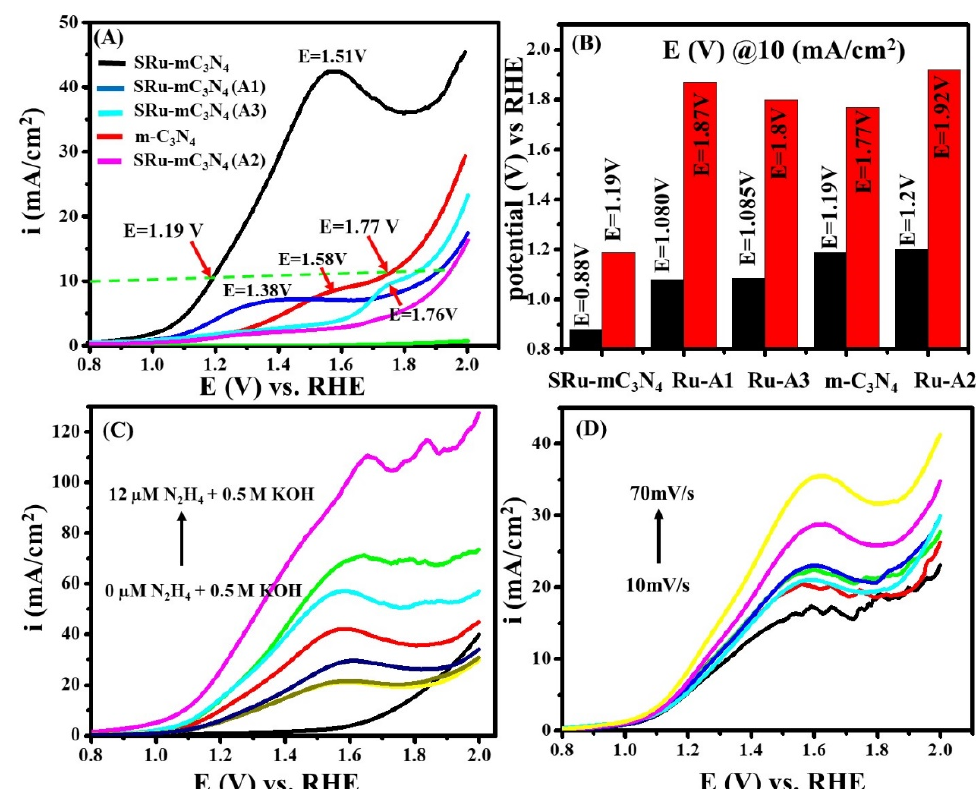
Figure 3. ( A ) Superimposed linear sweep voltammetry (LSV) for the bare GCE (green colour), SRu- mC 3 N 4 (A2), m-C 3 N 4 , SRu-mC 3 N 4 (A3), SRu-mC 3 N 4 (A1), and SRu-mC 3 N 4 in 6 μM N 2 H 4 + 0.5 M KOH at 50 mV/s. ( B ) Histogram of onset (black bar) oxidation potential and 10 mA/cm 2 (red bar) current density vs. RHE. Superimposed LSV for ( C ) SRu-mC 3 N 4 for different concentrations (0, 1, 2, 4, 6, 8, 10, 12 μM—black, yellow, dark yellow, blue, red, cyan, green, magenta in colour respectively) of hydrazine in 0.5 M KOH and ( D ) Scan-rate dependent studies using 4 μM N 2 H 4 in 0.5 M KOH at different scan rates in the range of 10–70 mV/s (black, red, cyan, green, blue, magenta, yellow colours for 10 to 70 mV/s respectively). Table 1. Comparison of different parameters from LSV data for 6 μM N 2 H 4 + 0.5 M KOH at a scan rate of 50 mV/s toward the bare GCE, m-C 3 N 4 , and SRu-mC 3 N 4 for potential at 1.3 V vs. RHE. Sr. No.